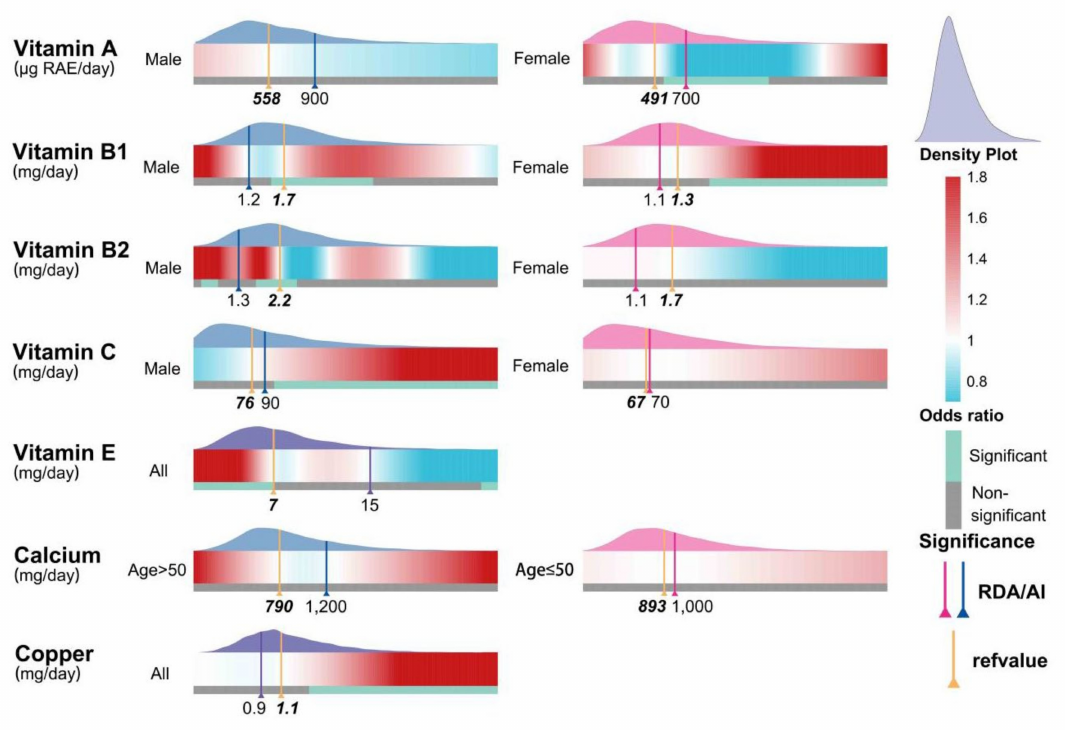
Figure 5. The RCS results after subgroup analysis for age or gender according to the reference threshold of DRI. RAE: retinol activity equivalents. Significance: intervals for the intake of significant micronutrients were determined based on odds ratio and confidence intervals. RDA: recommended dietary allowance; AI: adequate intake. Refvalue: the risk